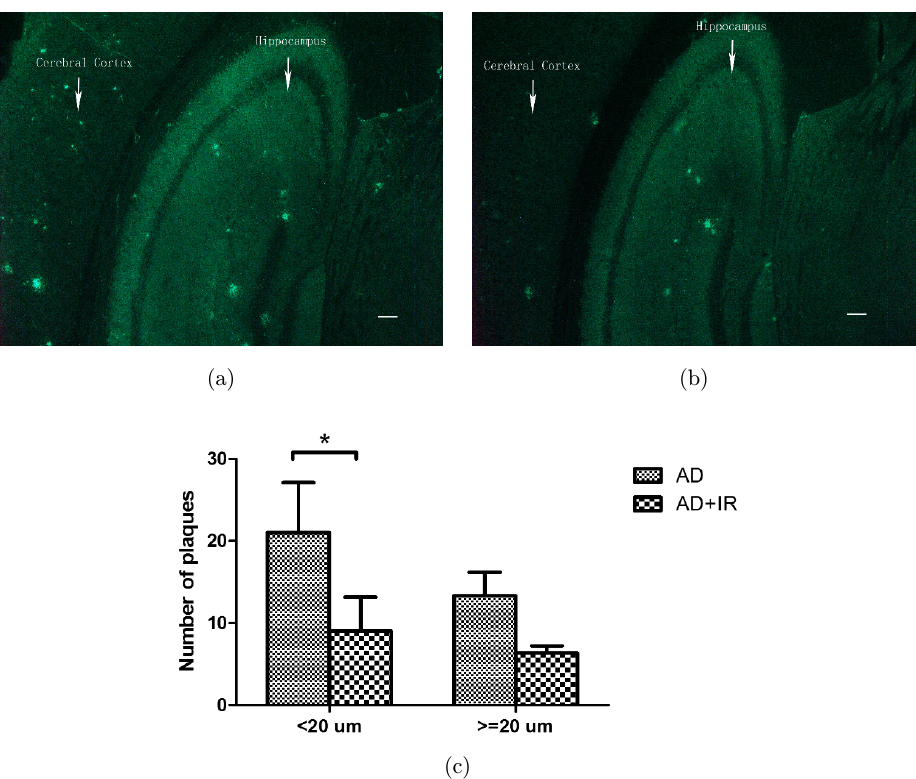
Fig. 3. Immuno°uorescence in hippocampus and cerebral cortex of mouse brains: ad ( n ¼ 4) and ad þ ir ( n ¼ 3) groups. Scale bar ¼ 100 (cid:4) m. Representative images of (a) ad, and (b) ad þ ir groups of mice; (c) Statistical analysis of plaques in the two groups. Plaques were divided into two categories: (cid:4) 20 (cid:4) m and < 20 (cid:4) m. All the data represent means (cid:2) SEM. There was signi¯cant di®erence ( p < 0.05) between the two groups for plaques measuring < 20 (cid:4) m. And for those measuring (cid:4) 20 (cid:4) m, p value was bigger than